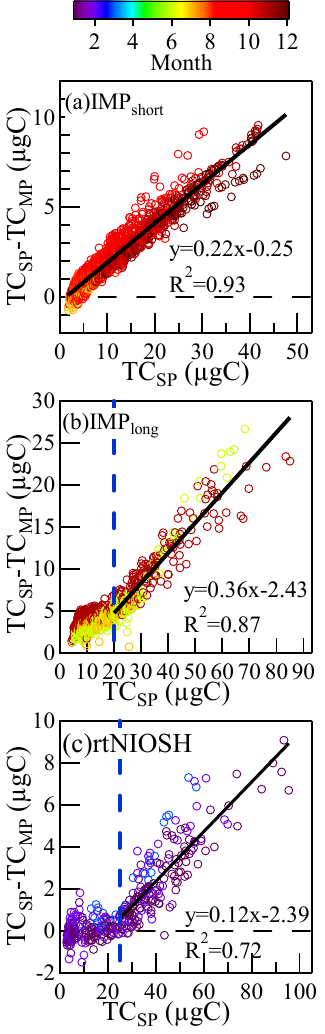
Figure 3. Calculation discrepancy quantification for ambient sam- Calculation discrepancy quantification for ambient samples analyzed with (a) 520 ples analyzed with (a) IMPshort, (b) IMPlong and (c) rtNIOSH pro- IMPshort, (b)IMPlong and (c) rtNIOSH protocol. 521 tocol.